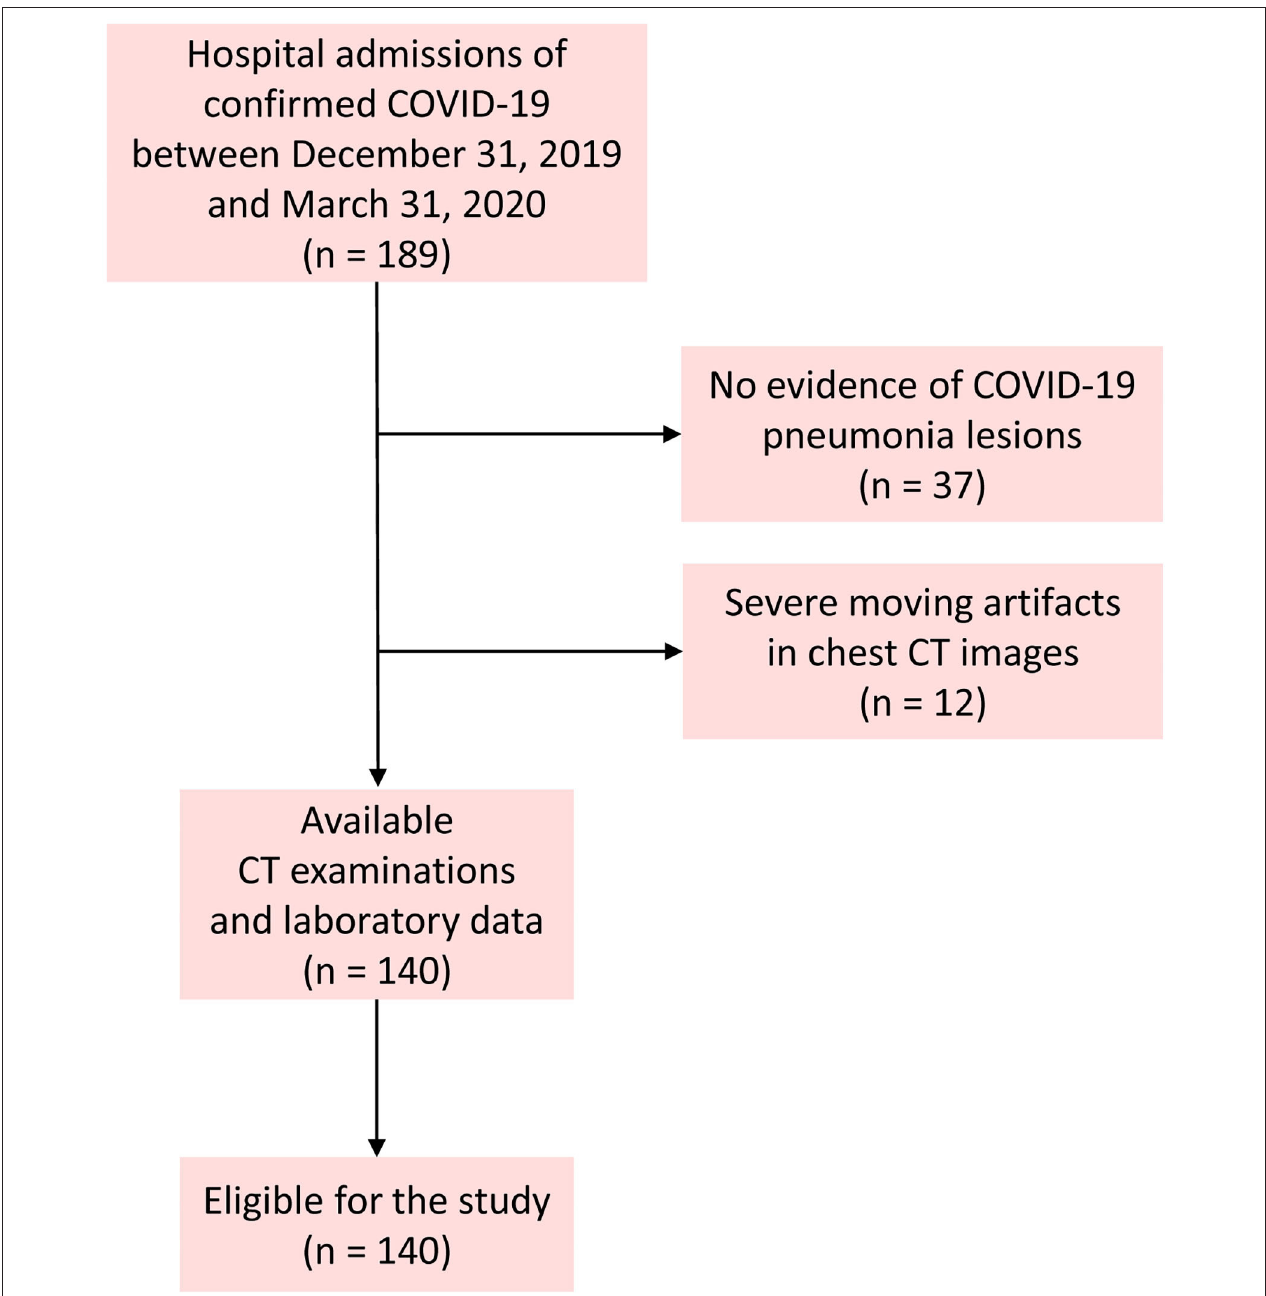
FIGURE 1 | Flowchart of the patient inclusion.